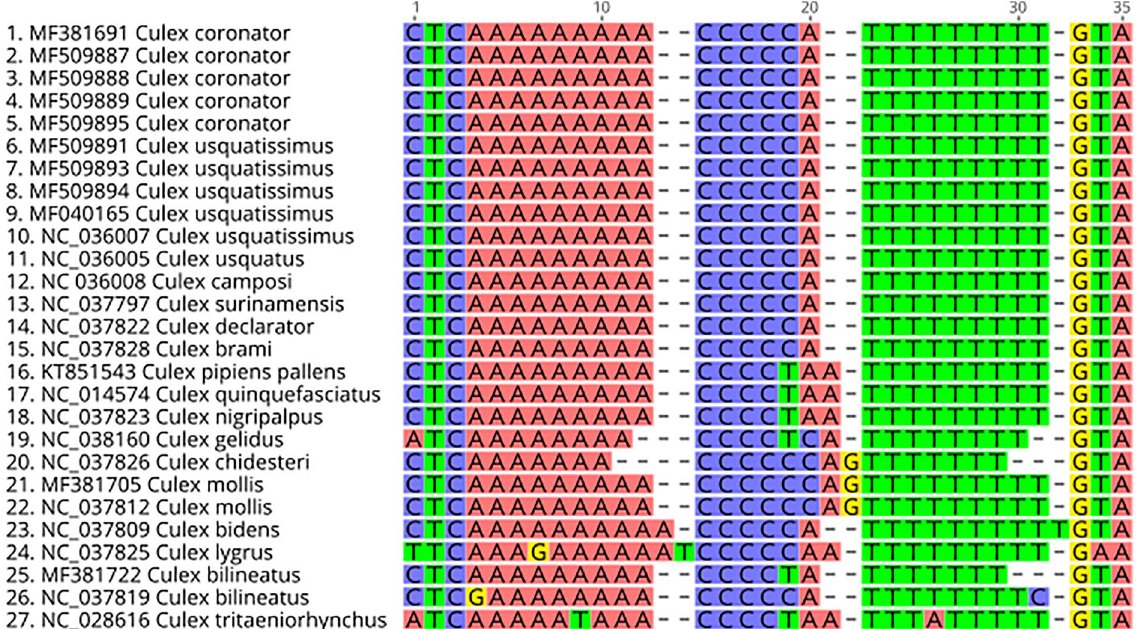
Figure 3. Comparison of 27 Culex Short motif and mirrored A and T stretches. Note mirrored mutations in 26. NC_037819 (G in position 4 and C in position 31) and 27. NC_028616 (T in position 9 and A in position 26). Generated with Geneious R11.1 (https:// www. genei ous.